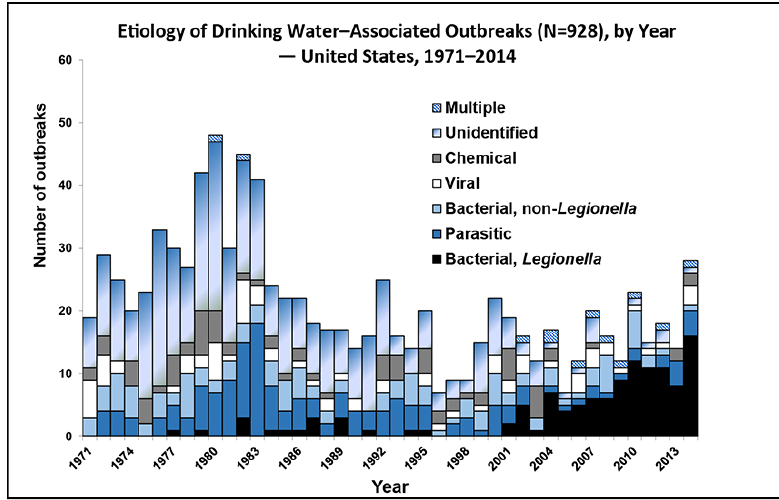
Figure 1. Etiology of 928 drinking water—associated outbreaks, by year-United States, 1971–2014 [6].